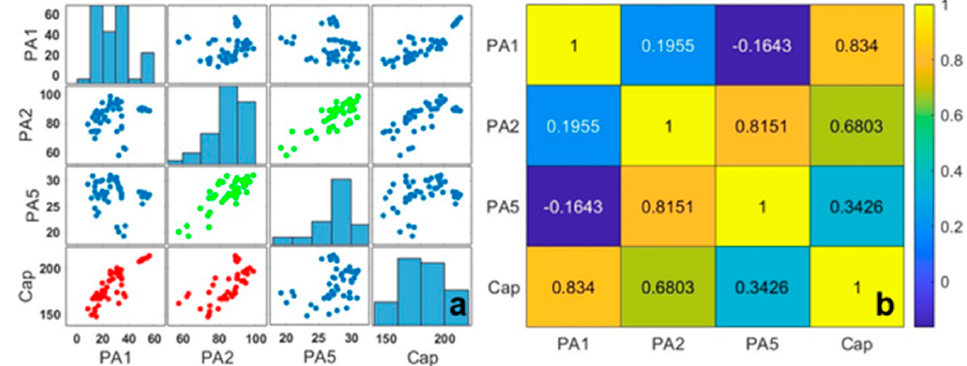
Figure 5. Correlation scatter diagram ( a ) and correlation thermodynamic diagram ( b ).